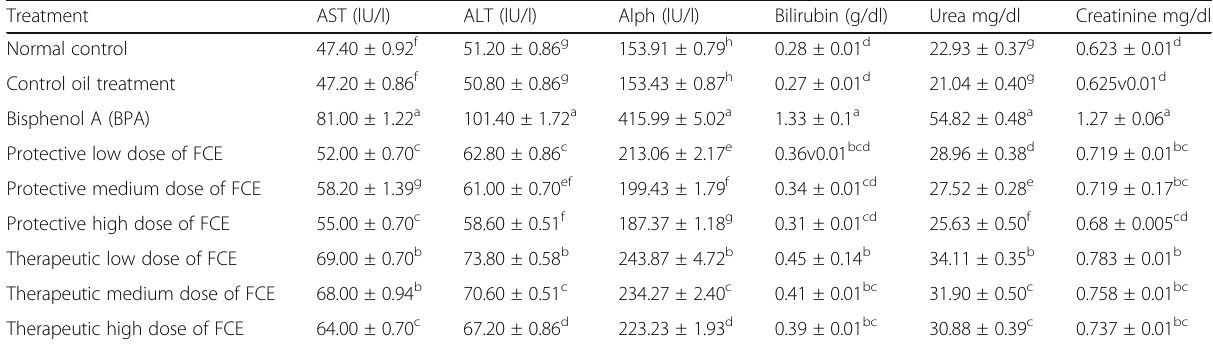
Table 6 Shows liver and kidney functions of serum Bisphenol A-intoxicated rats treated with Fagonia cretica